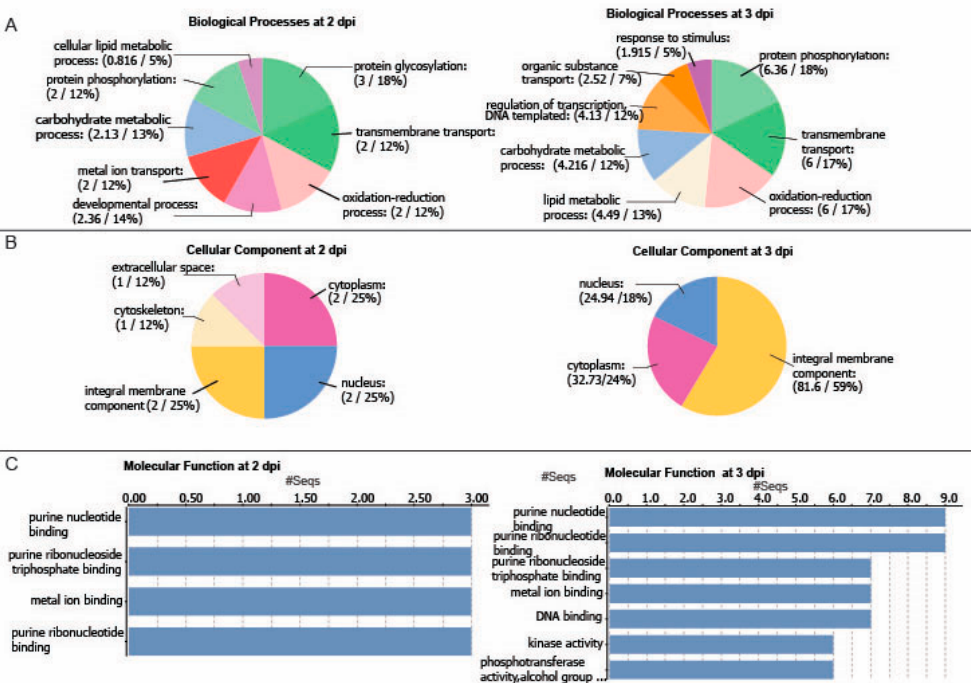
Figure 3. Summary pie charts and bar charts of GO analysis of DEGs that are downregulated transcripts at 2 and 3 dpi. The charts show the distribution of sequences according to the GO terms affiliated with ( A ) biological processes, ( B ) cellular components, and ( C ) molecular functions. The numbers and percentages of sequences are presented in parentheses with each slice in the pie charts.